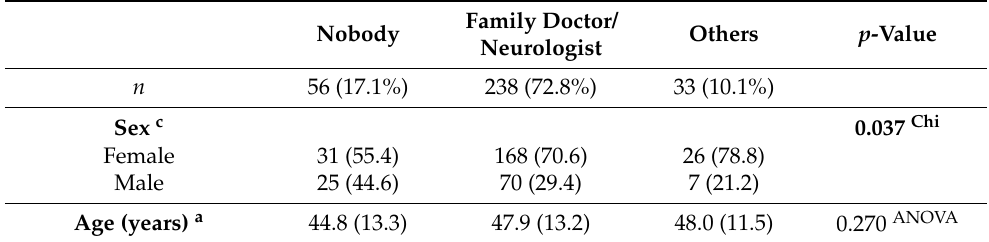
Table 4. Comparison of sociodemographic and clinical data between MS patients with different persons checking their vaccination